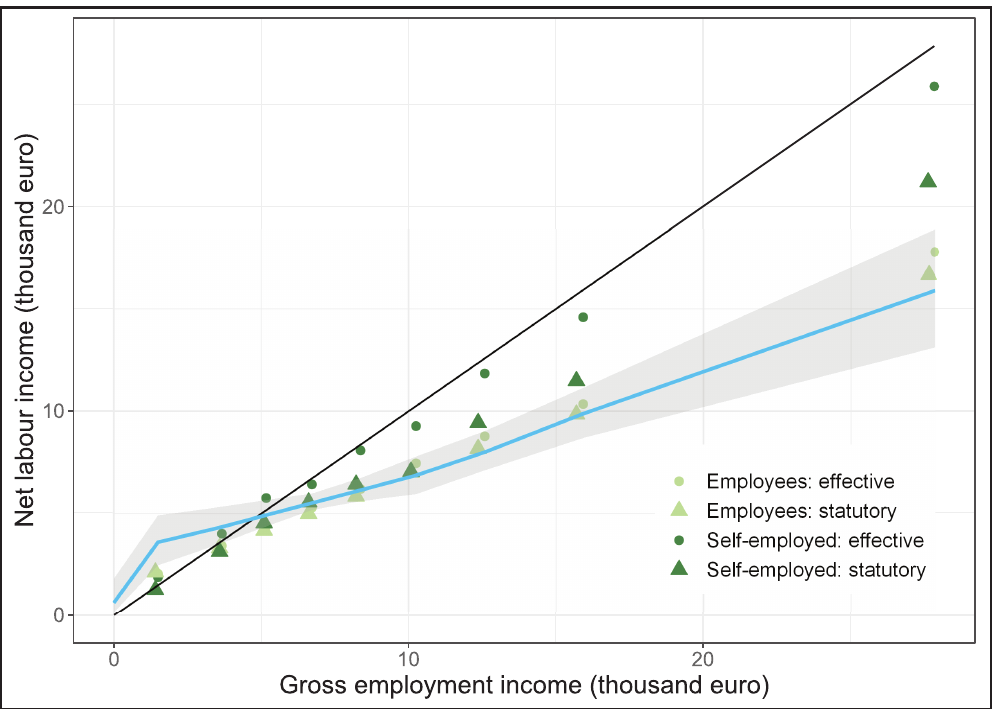
Figure 7 Statutory, effective, and optimal equivalized tax schedules for households grouped according to